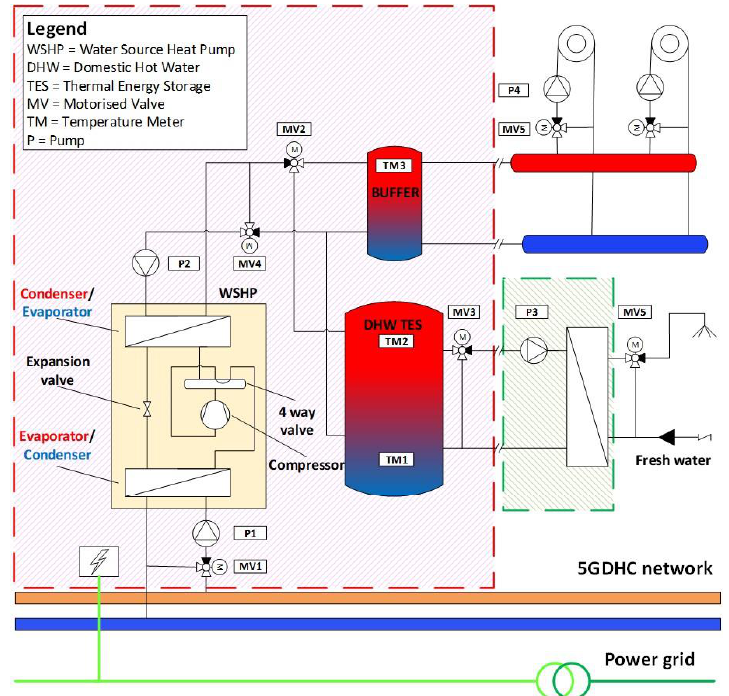
Figure 3. Hydraulic layout of a 5GDHC residential energy transfer station (dashed red boundary).